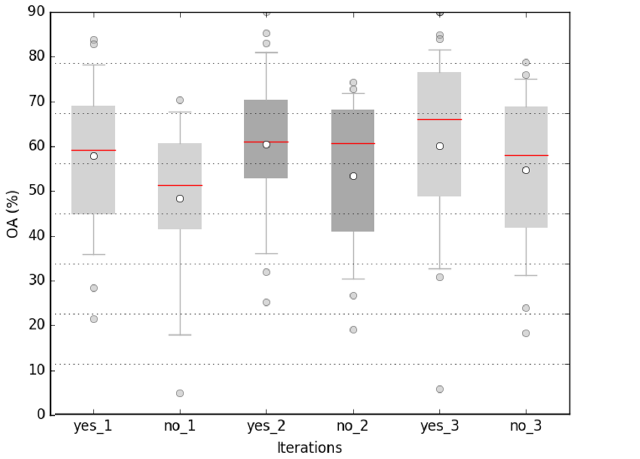
Figure 4. Boxplots of overall accuracies for each iteration depending on driving test. Median OA: red stripe; average OA: white dot; boxplot ends: first and third quantile; whiskers: + / − the 1.5-fold interquartile range on OA values and outliers: grey dots.